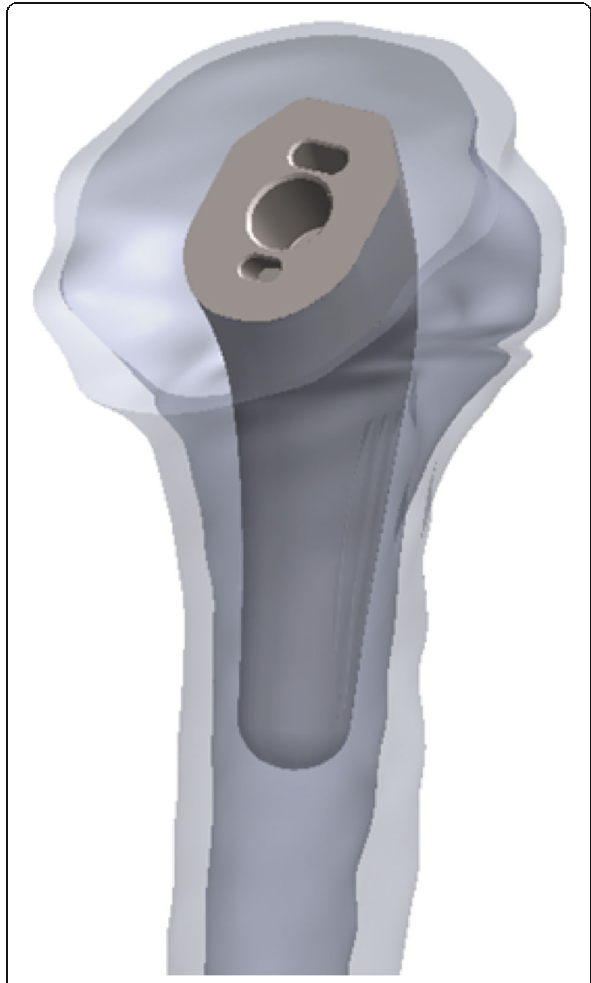
Fig. 2 Implant positioning in the generated bone model